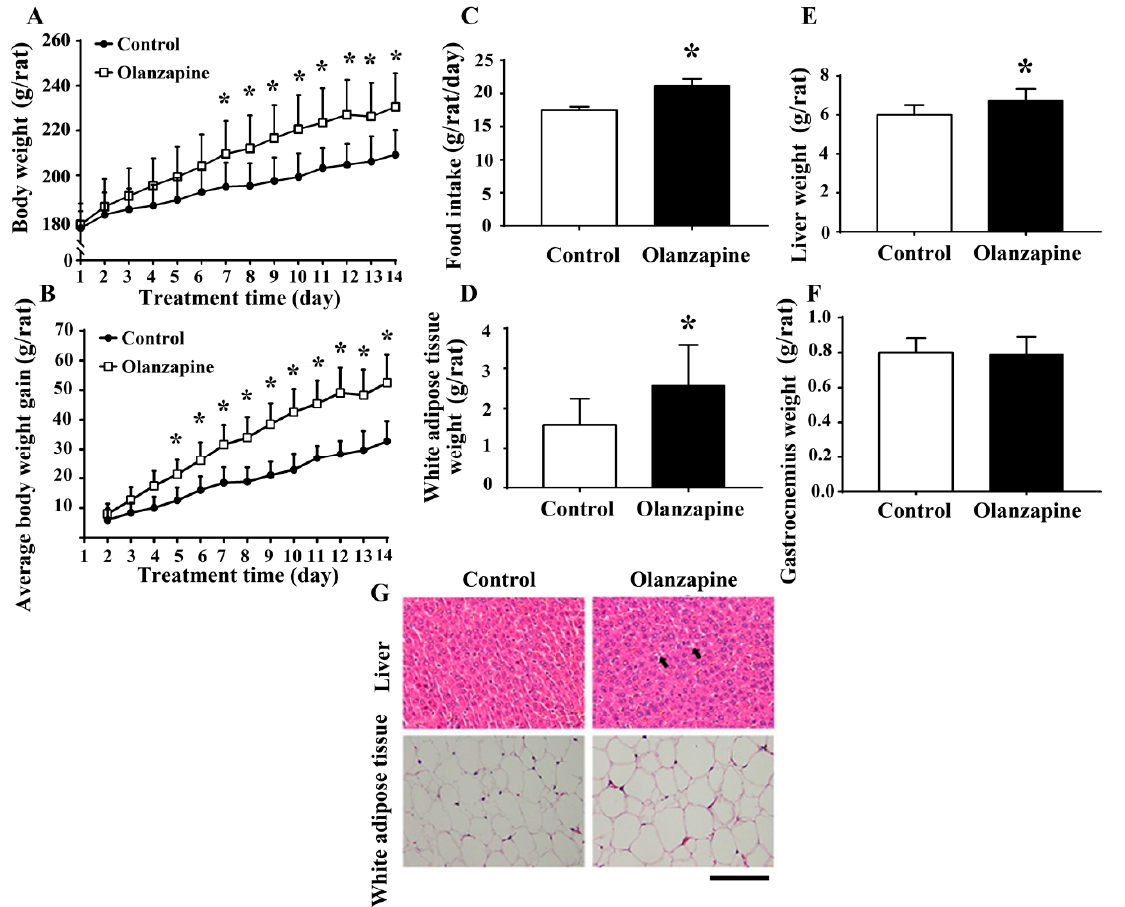
Figure 1. Olanzapine caused weight gain. During a course of 14 days, body weight and food intake were recorded over time. Daily changes in body weight ( A ), average body weight gain ( B ), and food intake ( C ) were summarized and depicted. At the end of the experiments, the weight of excised white adipose tissues ( D ), liver ( E ), and gastrocnemius ( F ) was measured. ( G ) The excised liver and perirenal white adipose tissues were subjected to histological examination. Representative photomicrographs of Hematoxylin and Eosin (H&E) stain are shown. * p < 0.05 vs. control, n = 10. Scale Bar: 0.1 mm. Arrows indicate a deposition of lipid droplets.